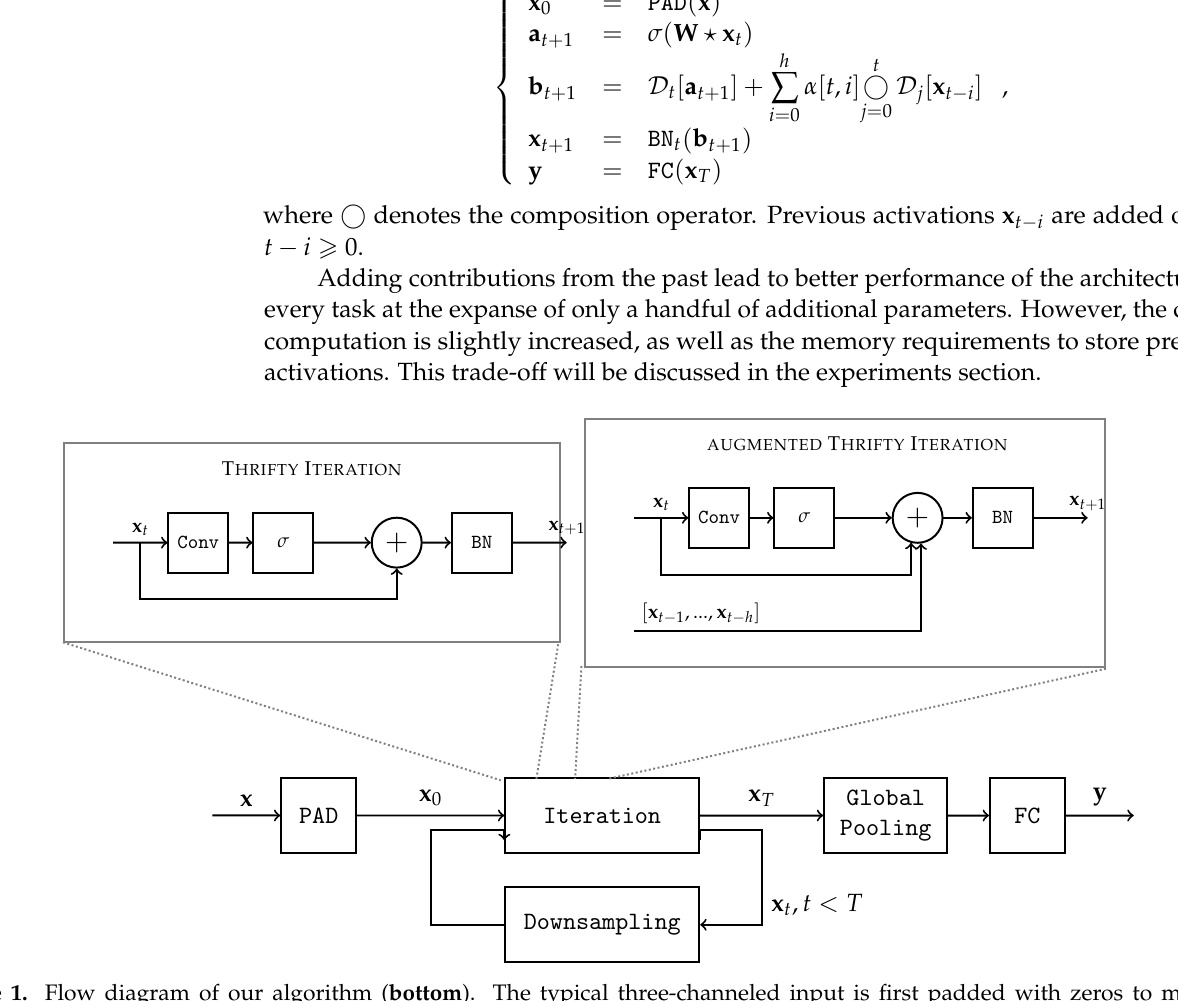
Figure 1. Flow diagram of our algorithm ( bottom ). The typical three-channeled input is first padded with zeros to match a predetermined number of filters. Then, ThriftyNet performs a user-defined amount of iterations T , consisting of a convolution with the filter, a non-linear activation, a shortcut and a Batch Normalization ( left box). Alternatively, an augmented ThriftyNet performs the same operation, as well as a weighted sum of this result with previous iterations before the normalization step ( right box). In both cases, the final tensor x T is fed into a global max pooling, extracting one feature per filter, and into a fully connected layer, connecting it to the output classes. The resulting architecture contains very few parameters mostly determined by the number of feature maps in the convolutional